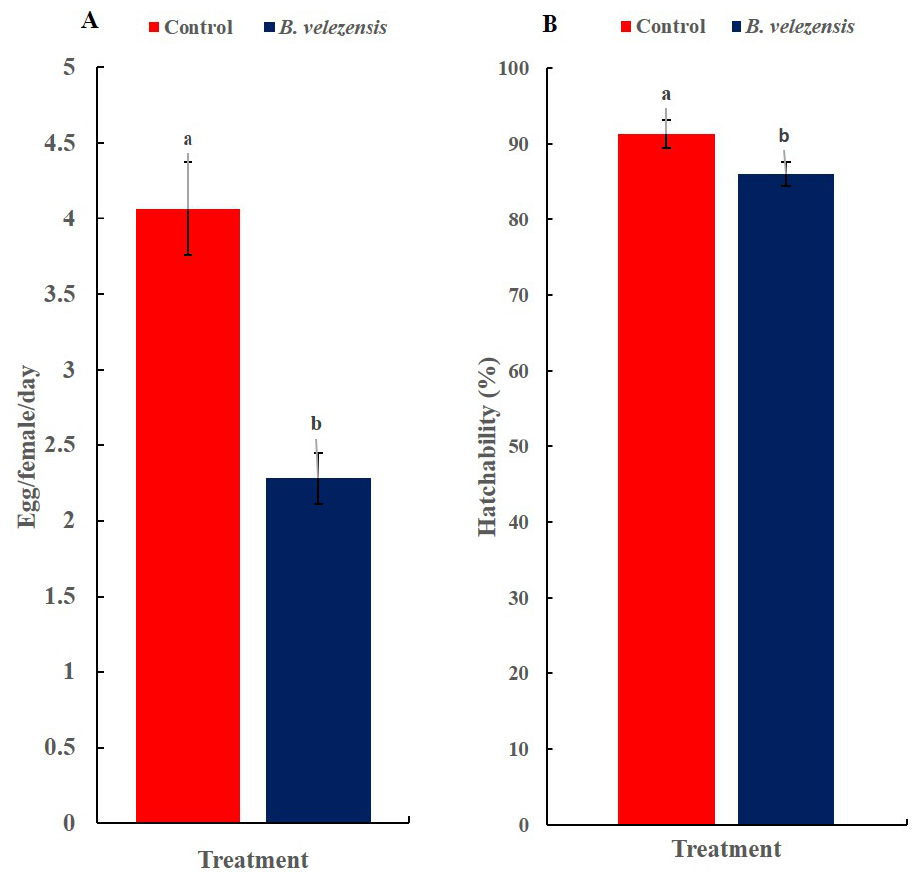
Figure 5. The effect of squash plants’ inoculation with Bacillus velezensis on ( A ) the daily mean number and ( B ) hatchability of laid eggs by Bemisia tabaci females.